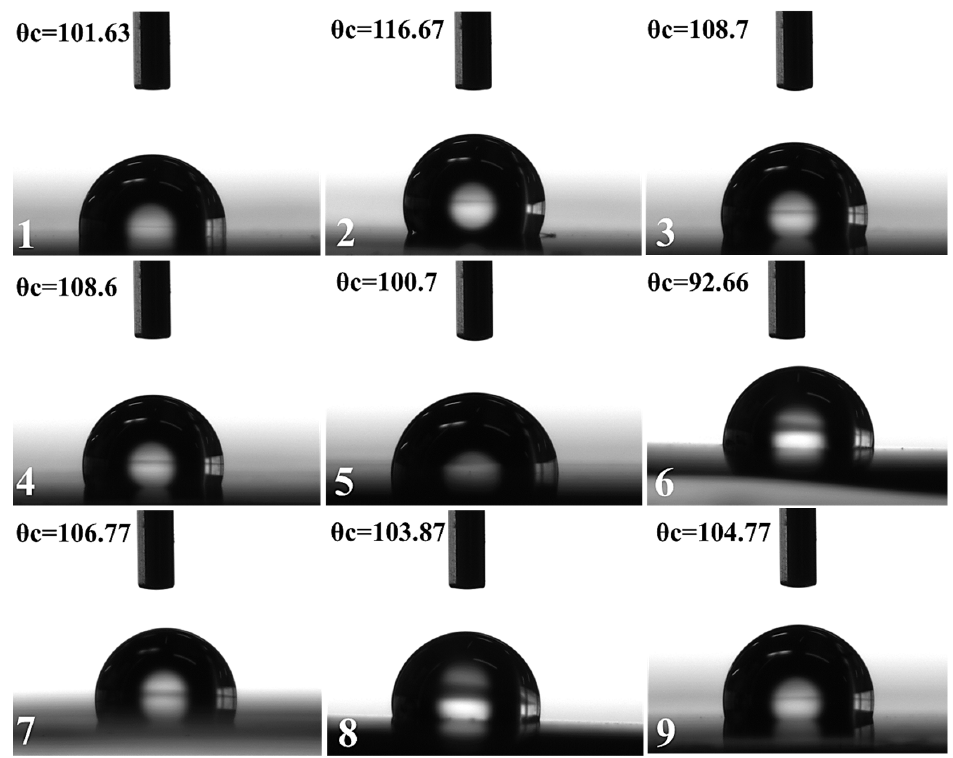
Figure 9. Digital images of contact angle ( θ c) between thin film samples 1–9 and the polar test liquid water at room temperature. Table 3. Surface free energy calculated from data of measured contact angle of silver-doped permalloy flexible thin films.